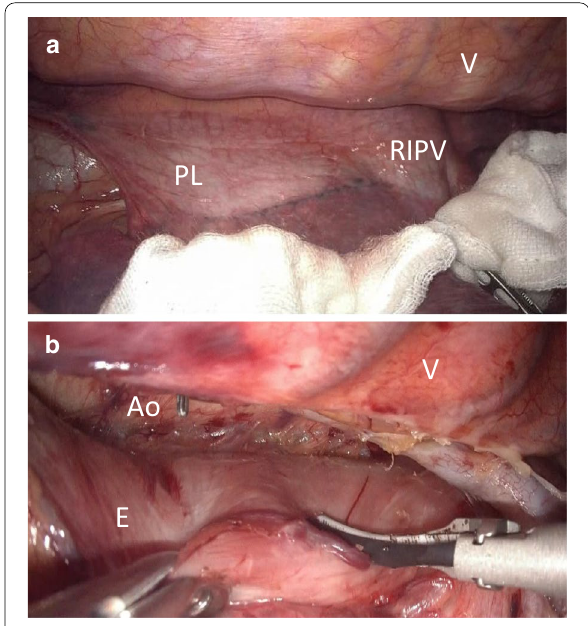
Fig. 2 Thoracoscopic intraoperative findings of Patient 1. a Top-down visual field at the start of surgery. b Bottom-up visual field and the posterior mediastinum was found to be narrow because of pectus excavatum. V Vertebra, PL pulmonary ligament, RIPV right inferior pulmonary vein, E esophagus, Ao aorta